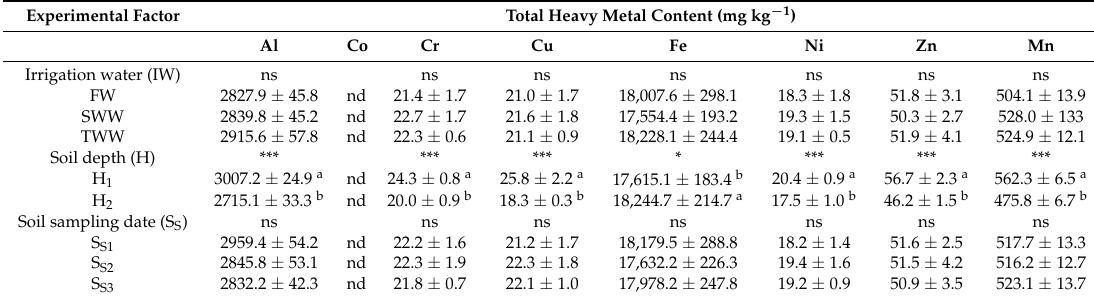
Table 2. Main effects of the irrigation waters, soil depths, and soil sampling dates on the total soil heavy metal